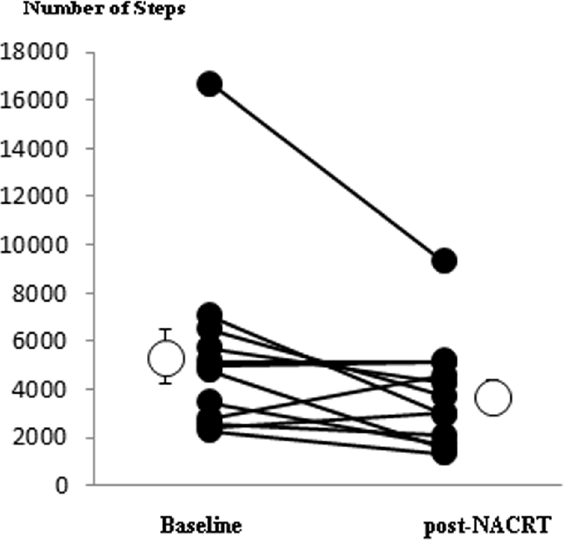
Figure 3. Averaged number of steps at Baseline (before NACRT)) and at 48 ¡ 5 hours post-NACRT: lines link data-points (closed circles) for individual patients, and open circles show overall mean ¡ SEM. Mean change (SEM) between baseline and post-NACRT is 2 1627(712) steps, p 5